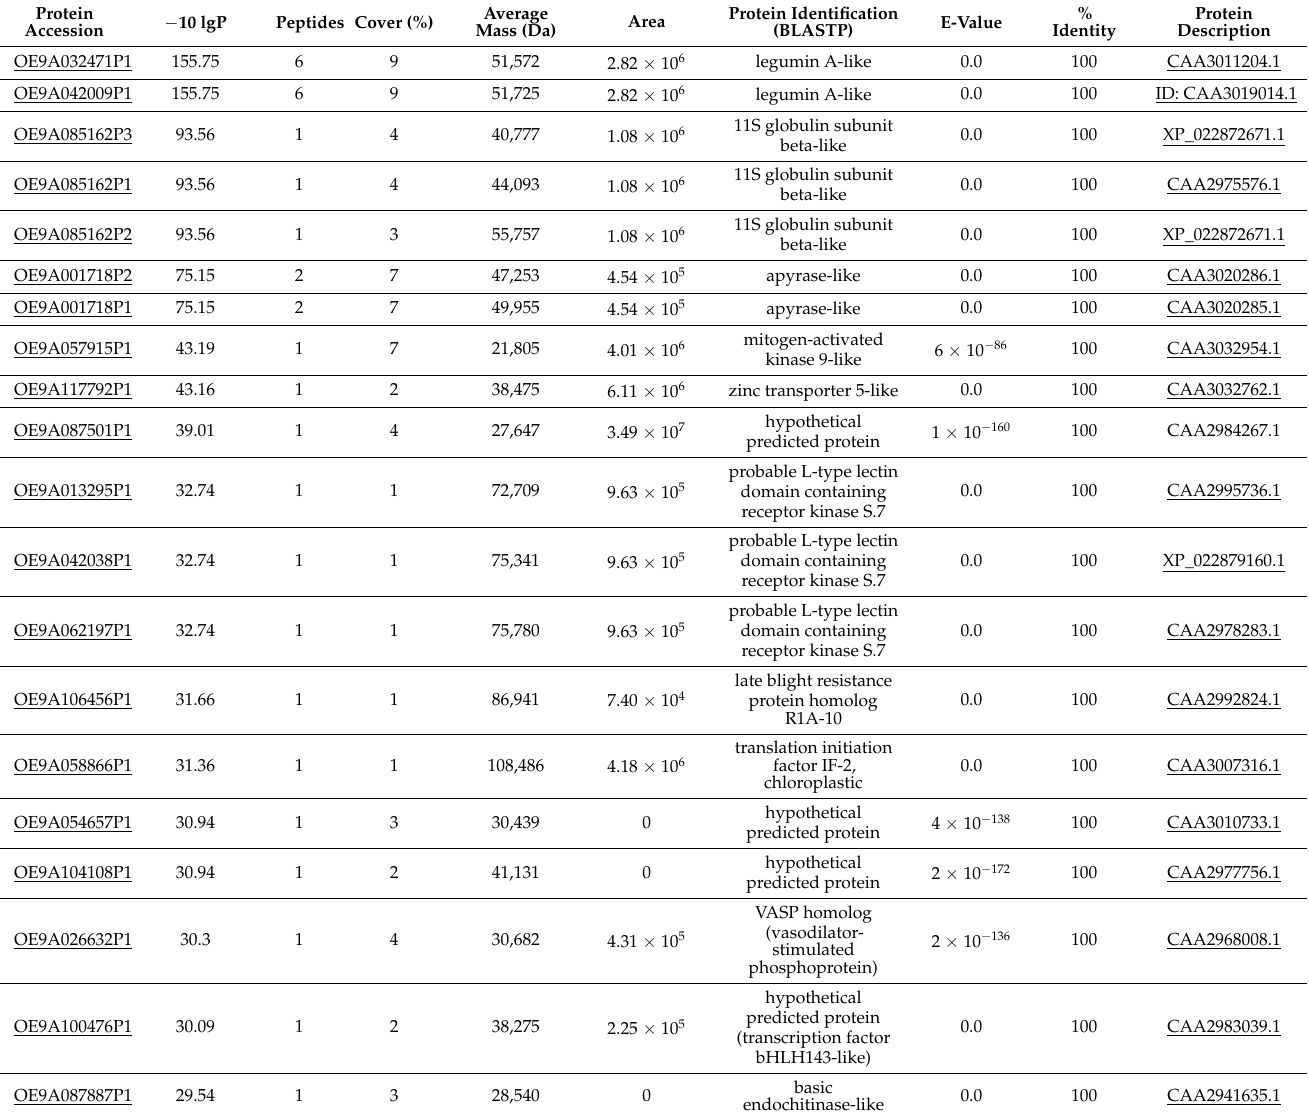
Table 2. Proteins identified as sources of endogenous peptides detected in virgin olive oil: protein − 10 lgP score, sum of − 10 lgP scores of a protein’s supporting peptides; peptides, number of high- confidence supporting peptides; cover (%), percentage of the protein sequence covered by supporting peptides; area, protein relative abundance; protein identification, definitions of best-matched proteins identified by BLAST-P search; E-value (score), number of expected hits of similar quality that could be found randomly; protein description, access to protein